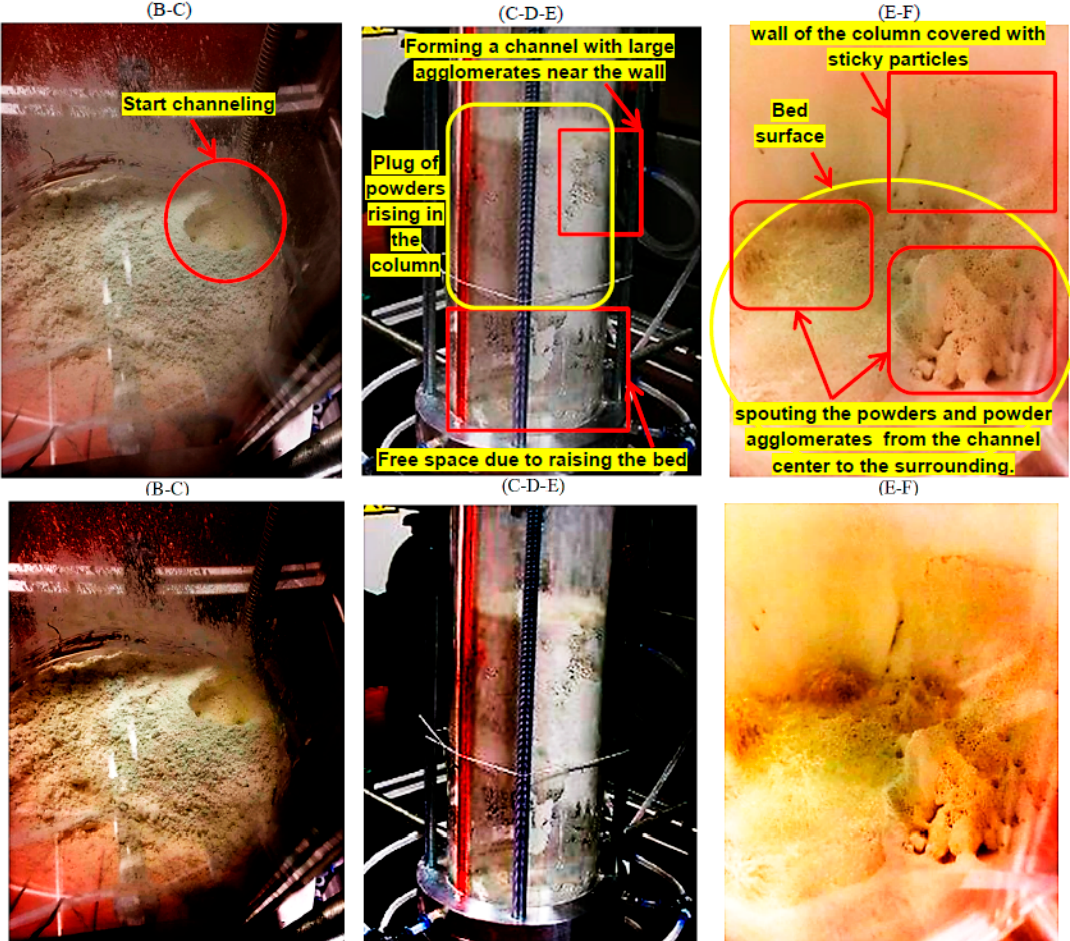
Figure 6. Three different behaviours of ultra-fine particle fluidization during the first test shown in Figure 5: First row: (B-C) start channelling and decrease of bed pressure drop; (C-D-E) rising of the upper part of the bed as a plug in the fluidization columns, accompanied by a competition between formation and destruction of some small channels in the raised bed; (E-F) top view of bed surface showing the wall of the column covered with sticky particles and some large channels after collapse of the raised bed, spouting the powders and powder agglomerates from the channel centre to the surrounding—Second row: High-contrast pictures for better observations .